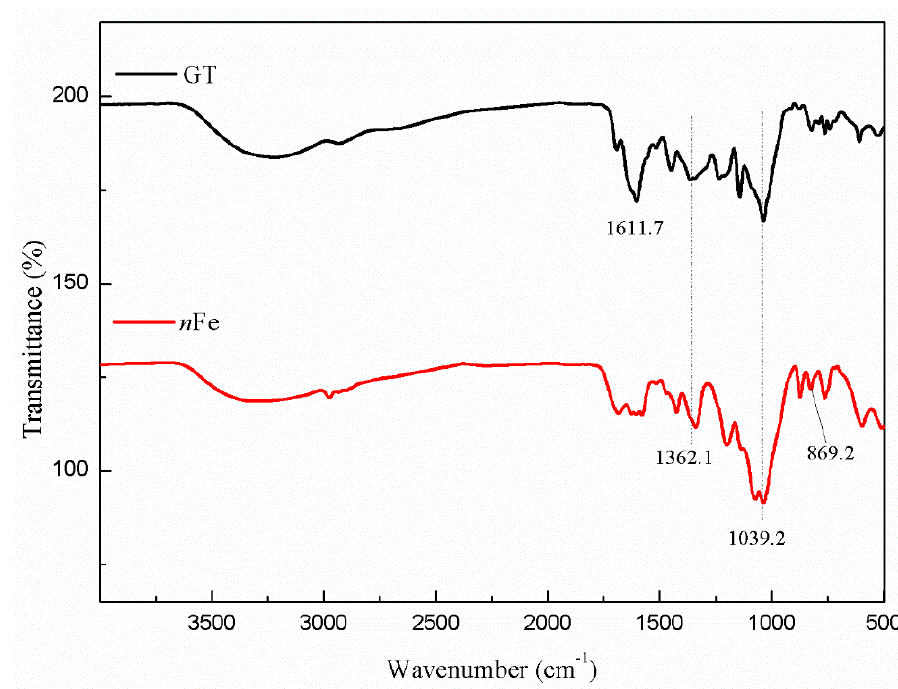
Figure 6. FT-IR spectra of GT (black line) and n Fe (red line).